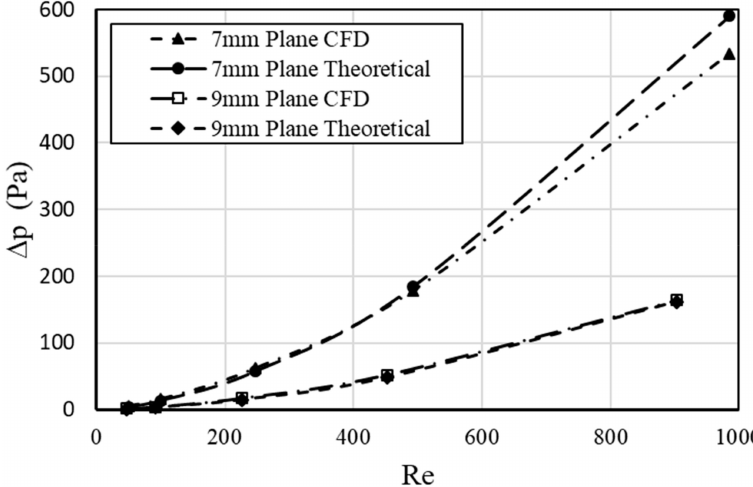
Figure 7. Comparison of the total pressure drop results by using the CFD simulation and the theoretical approach.